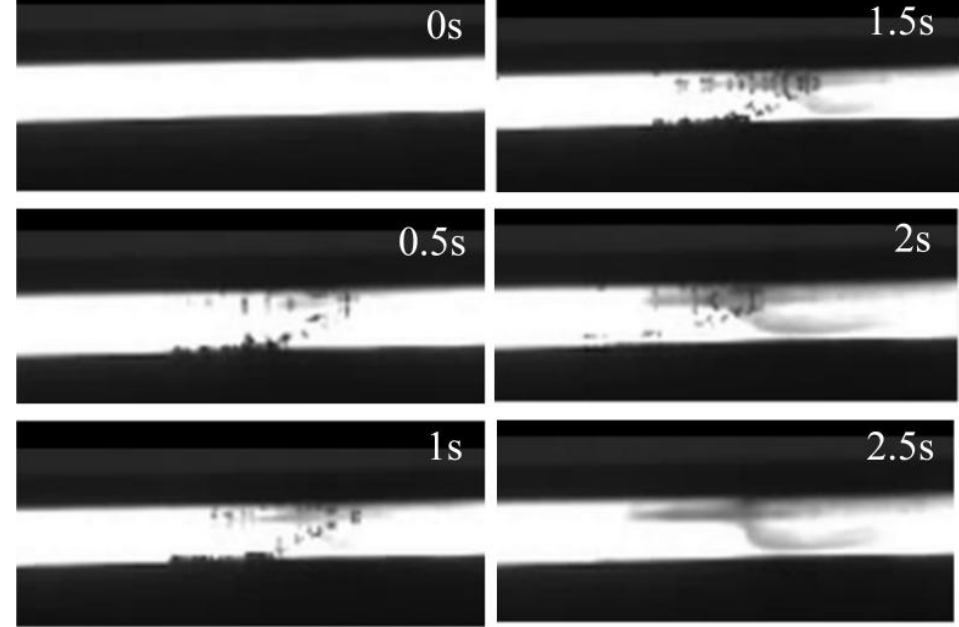
Figure 8. Time sequence diagrams of bubbles floating in absolute ethanol.